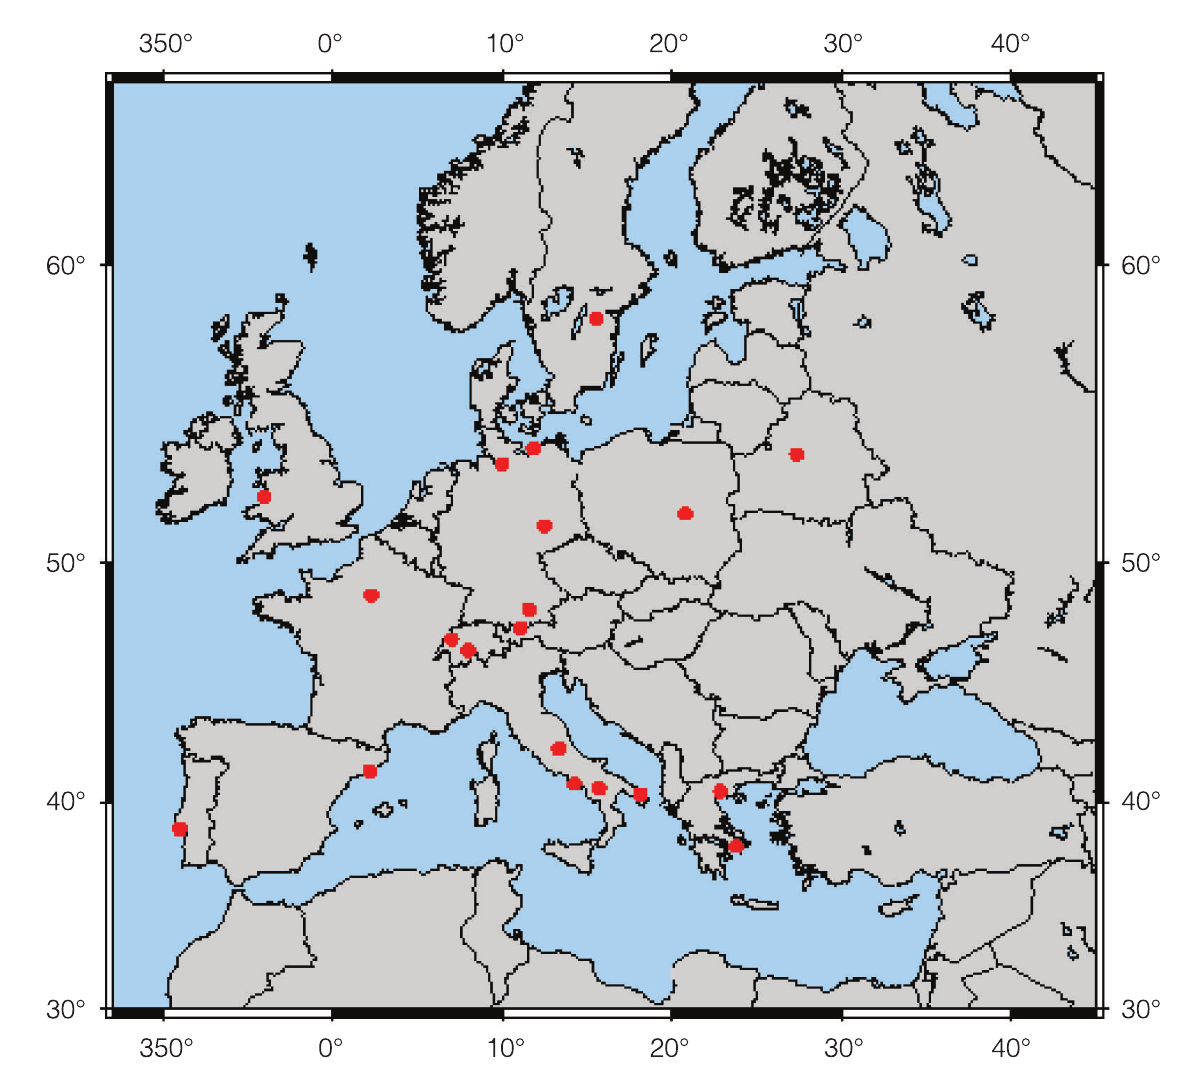
Fig. 1. Network of EARLINET